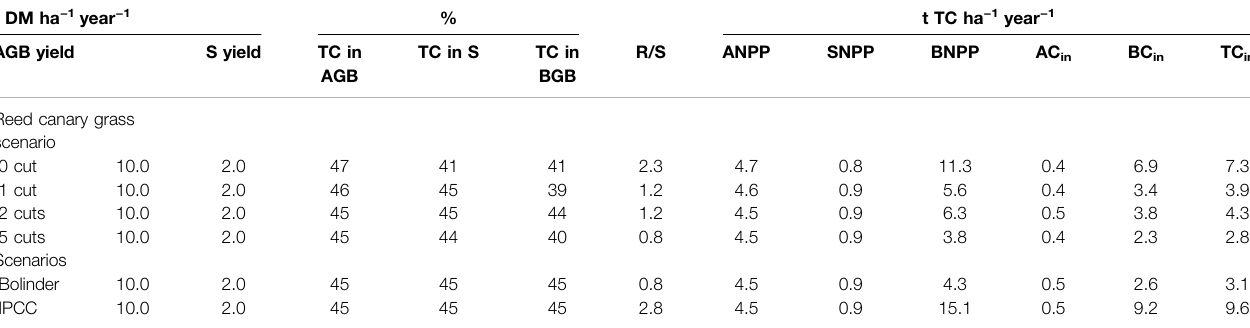
TABLE 6 | Calculation of the total carbon input into soil using averaged biomass yields on the example of reed canary grass and two literature-derived scenarios, applying different root to shoot (R/S) ratios. The contents of total carbon (TC) in aboveground (AGB), stubble (S), and belowground (BGB) biomass and the determined R/S were used for the calculation of aboveground net primary productivity (ANPP), stubble net primary productivity (SNPP), and belowground net primary productivity (BNPP), the inputofcarbon intosoilfromabovegroundbiomassresidues (AC in ),andbelowgroundbiomass(BC in ),resultinginthetotalcarbon input(TC in )overarootingdepthof50 cm. Yields are indicated in t dry matter (DM) ha − 1 year − 1